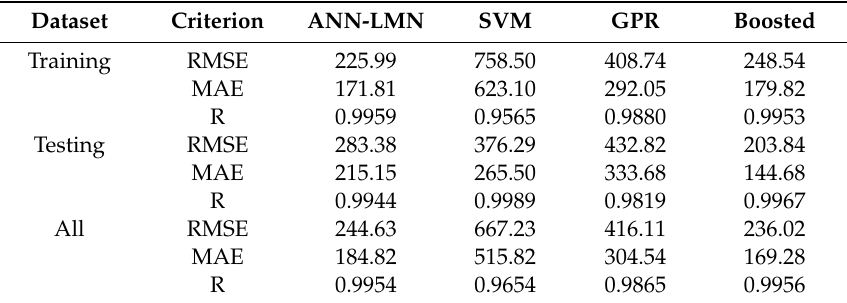
Table 5. Summary information of di ff erent machine learning algorithms.